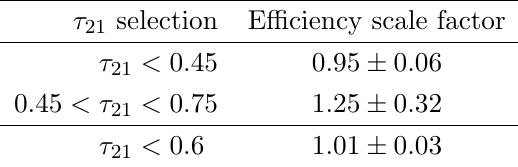
Table 1 . Data-to-simulation scale factors for the e(cid:14)ciency of the (cid:28) 21 selection used in the analyses, as extracted from top quark enriched data and from simulation.